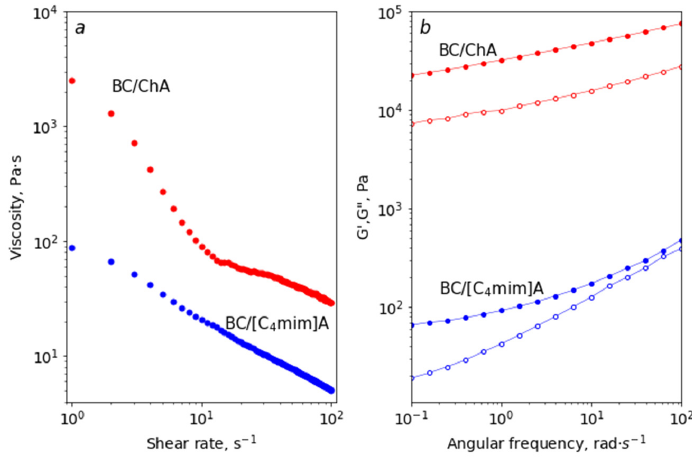
Figure 6. Dependence of the viscosity on the shear rate ( a ); storage (G ′ , filled symbols) and loss (G ″ , hollow symbols) moduli as a function of angular frequency ( b ) for BC/ChA and BC/[C 4 mim]A dispersions.